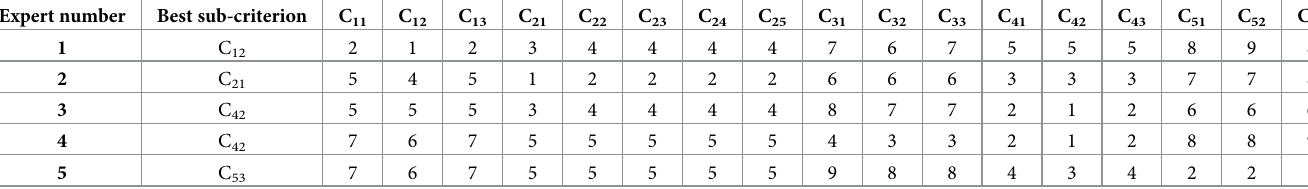
Table 5. Results of the significance comparison for the best sub-criterion with others. Expert number Best